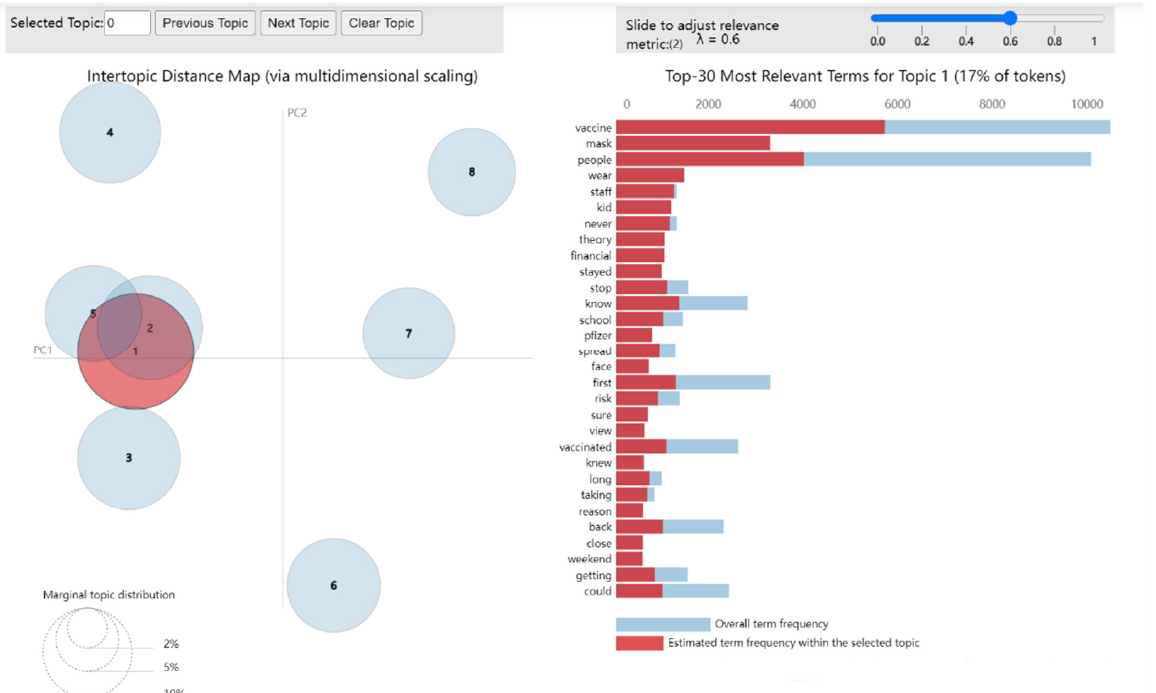
Figure 4. The inter-topic distance map. 1. saliency (term w) = frequency(w)* [sum t p (t|w) * log (p (t|w/p(t))] for topics t; see [68]. 2. relevance (term w|topic t) = λ * p (w|t) + (1 − λ ) *p (w|t)/p(w); see [67].